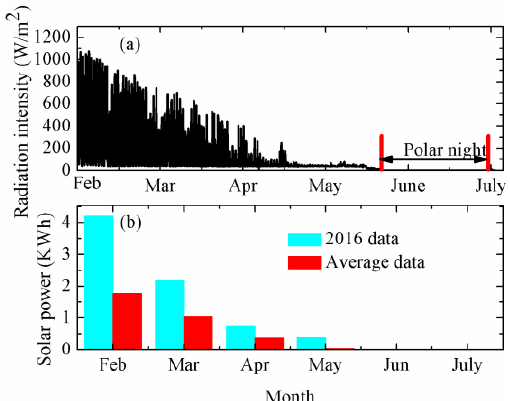
Figure 19. ( a , b ) Daily radiation intensity measured by the observing system, and solar power generated by the power system from 6 February 2017 to 9 July 2017, respectively. Area between the red lines is the polar night.